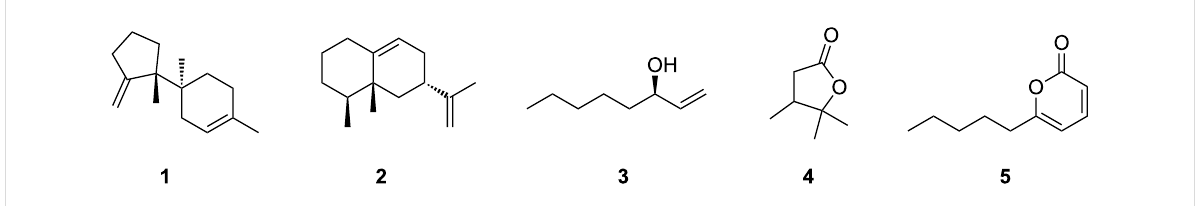
Figure 1: Structures of fungal volatiles. Trichodiene ( 1 ), aristolochene ( 2 ), ( R )-oct-1-en-3-ol ( 3 ), 3,4-dimethylpentan-4-olide ( 4 ), and 6-pentyl-2 H - pyran-2-one ( 5 ).